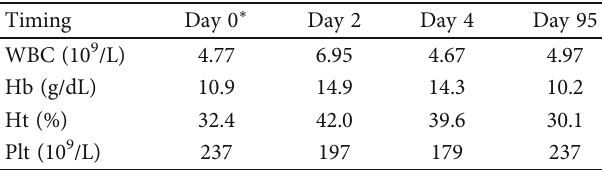
Table 2: The changes in neonatal complete blood